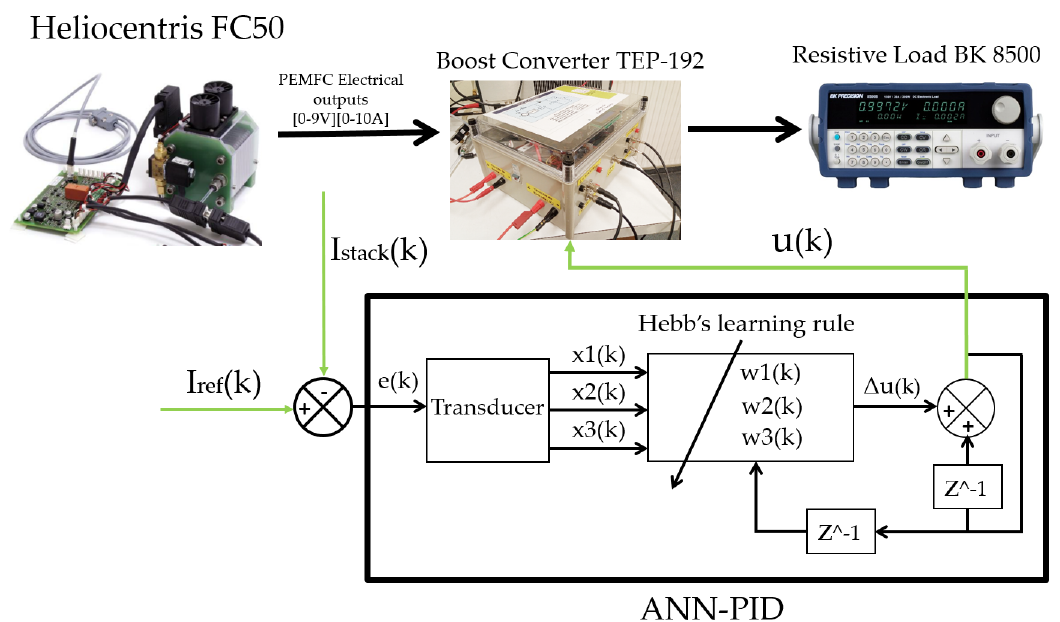
Figure 10. Implementation of ANN-PID on Heliocentris FC50 hardware system. The output of the ANN-PID controller ∆ u ( k ) is given in Equation (6), where k is a positive parameter determined by the user, and the values of the three inputs x i are given in Equation